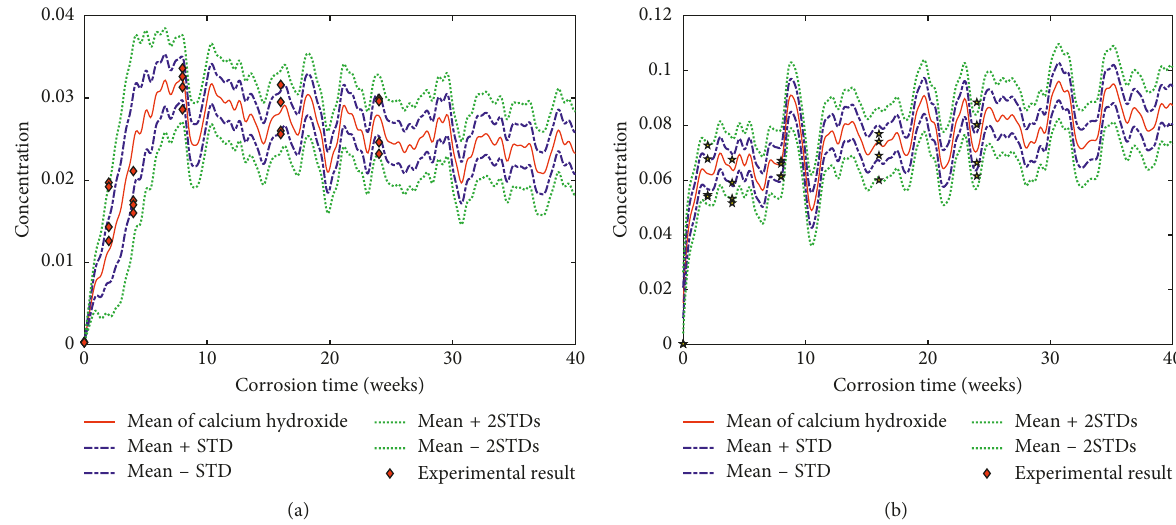
Figure 14: Comparison of the theoretical predictions and experimental data of (a) gypsum and (b) ettringite in corrosion products, where variations of the initial concentrations of sodium sulfate and ettringite are also considered in the